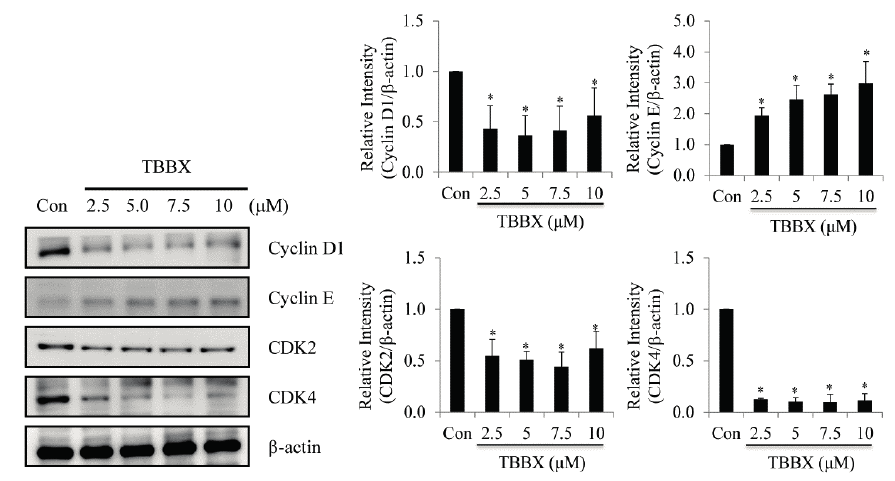
Figure 3. Effects of TBBX on the expressions of cyclins, and CDKs in H1299 lung cancer cells. H1299 lung cancer cells were initially synchronized by serum-free medium and then serum-supplemented medium containing various doses of TBBX (0, 2.5, 5, 7.5, and 10 μ M). After the cells were harvested, Western blot analyses were performed with anti-cyclin D1, E, CDK2, CDK4, and β -actin antibodies. Data shown are representative of at least three independent experiments. Significant difference was observed from the control group (* p <